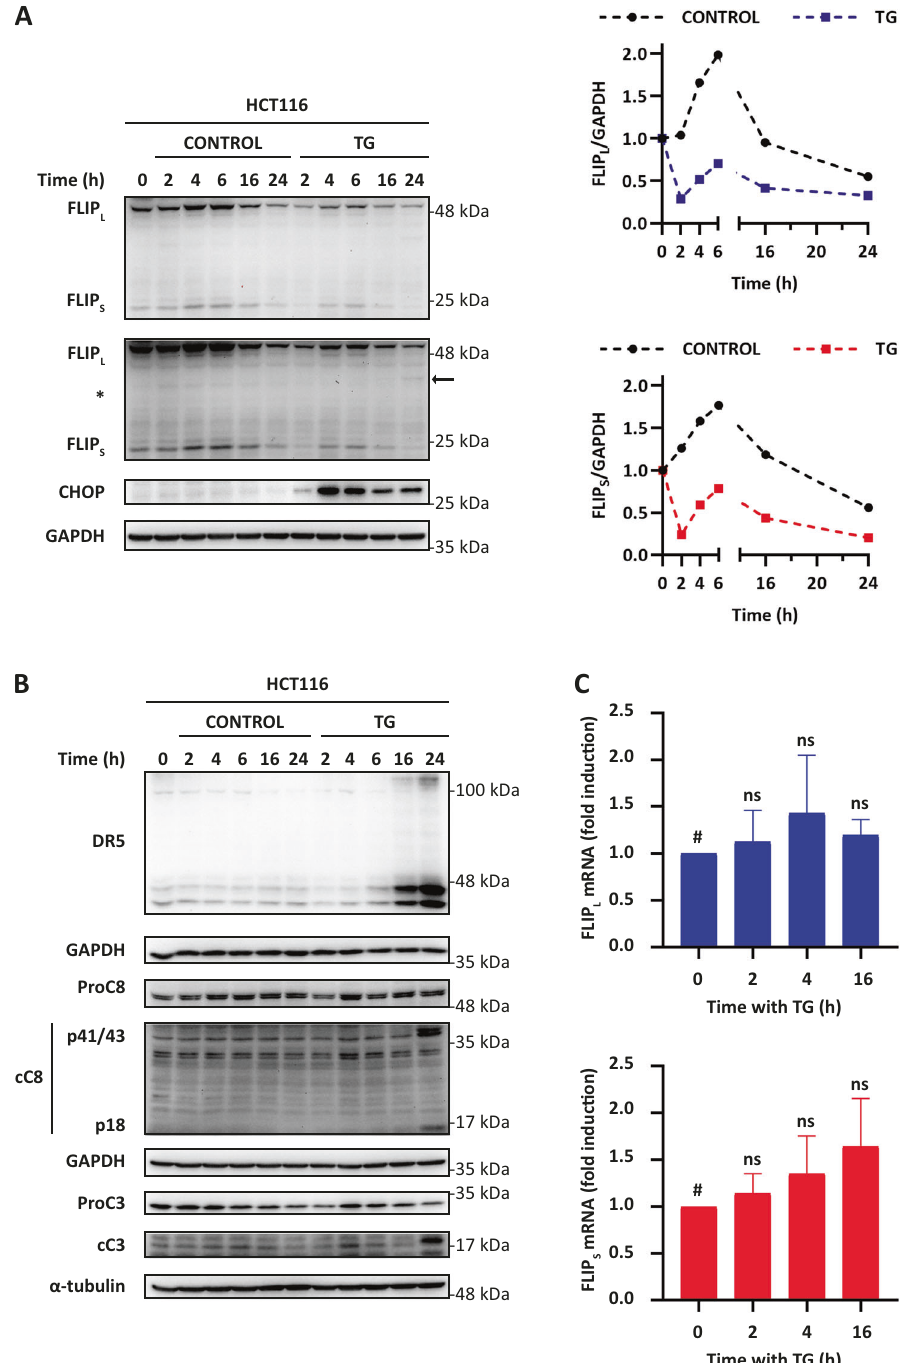
Fig. 1 cFLIP levels and caspase-8 activation upon ER stress in tumor cells. HCT116 cells were treated with TG (100 nM) for the indicated times. cFLIP and CHOP levels ( A ) as well as TRAIL-R2/DR5 upregulation, caspase-8 and caspase-3 processing ( B ) were determined in whole-cell extracts by western blotting. Levels of both cFLIP isoforms were quanti fi ed with Image Lab TM 6.0 software using GAPDH as protein-loading control and graphed relative to time 0 levels. Blots are representative of three independent experiments. In A , two different exposures of the western blot are shown to follow the levels of the short isoform of cFLIP. C HCT116 cells were treated with TG (100 nM) for the indicated times and mRNA relative levels of cFLIP L (upper panel) and cFLIP S (lower panel) were examined by RT-qPCR as described in materials and methods and referred to time 0 h levels (ns = not statistically signi fi cant. Unpaired t test with Welch ’ s silencing cFLIP L expression did not result in an alteration of the a caspase-8-dependent apoptotic program downstream of the levels of the PERK pathway markers when compared to cells upregulation of TRAIL-R2/DR5. Furthermore, we also examined the transfected with a control oligonucleotide. Furthermore, TRAIL-R2/ effect of cFLIP L knockdown on the activity of the PERK branch of DR5 upregulation induced by TG was not affected by silencing cFLIP L expression (Fig. S6A). the UPR upon ER stress. As shown in Supplementary Fig. S6A